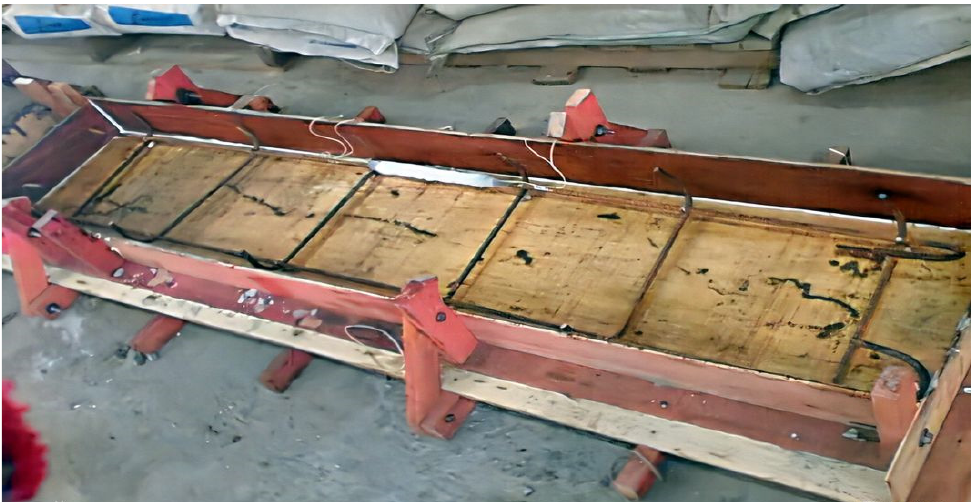
Figure 4. Longitudinal reinforcement utilized in the tested one-way RC slabs.